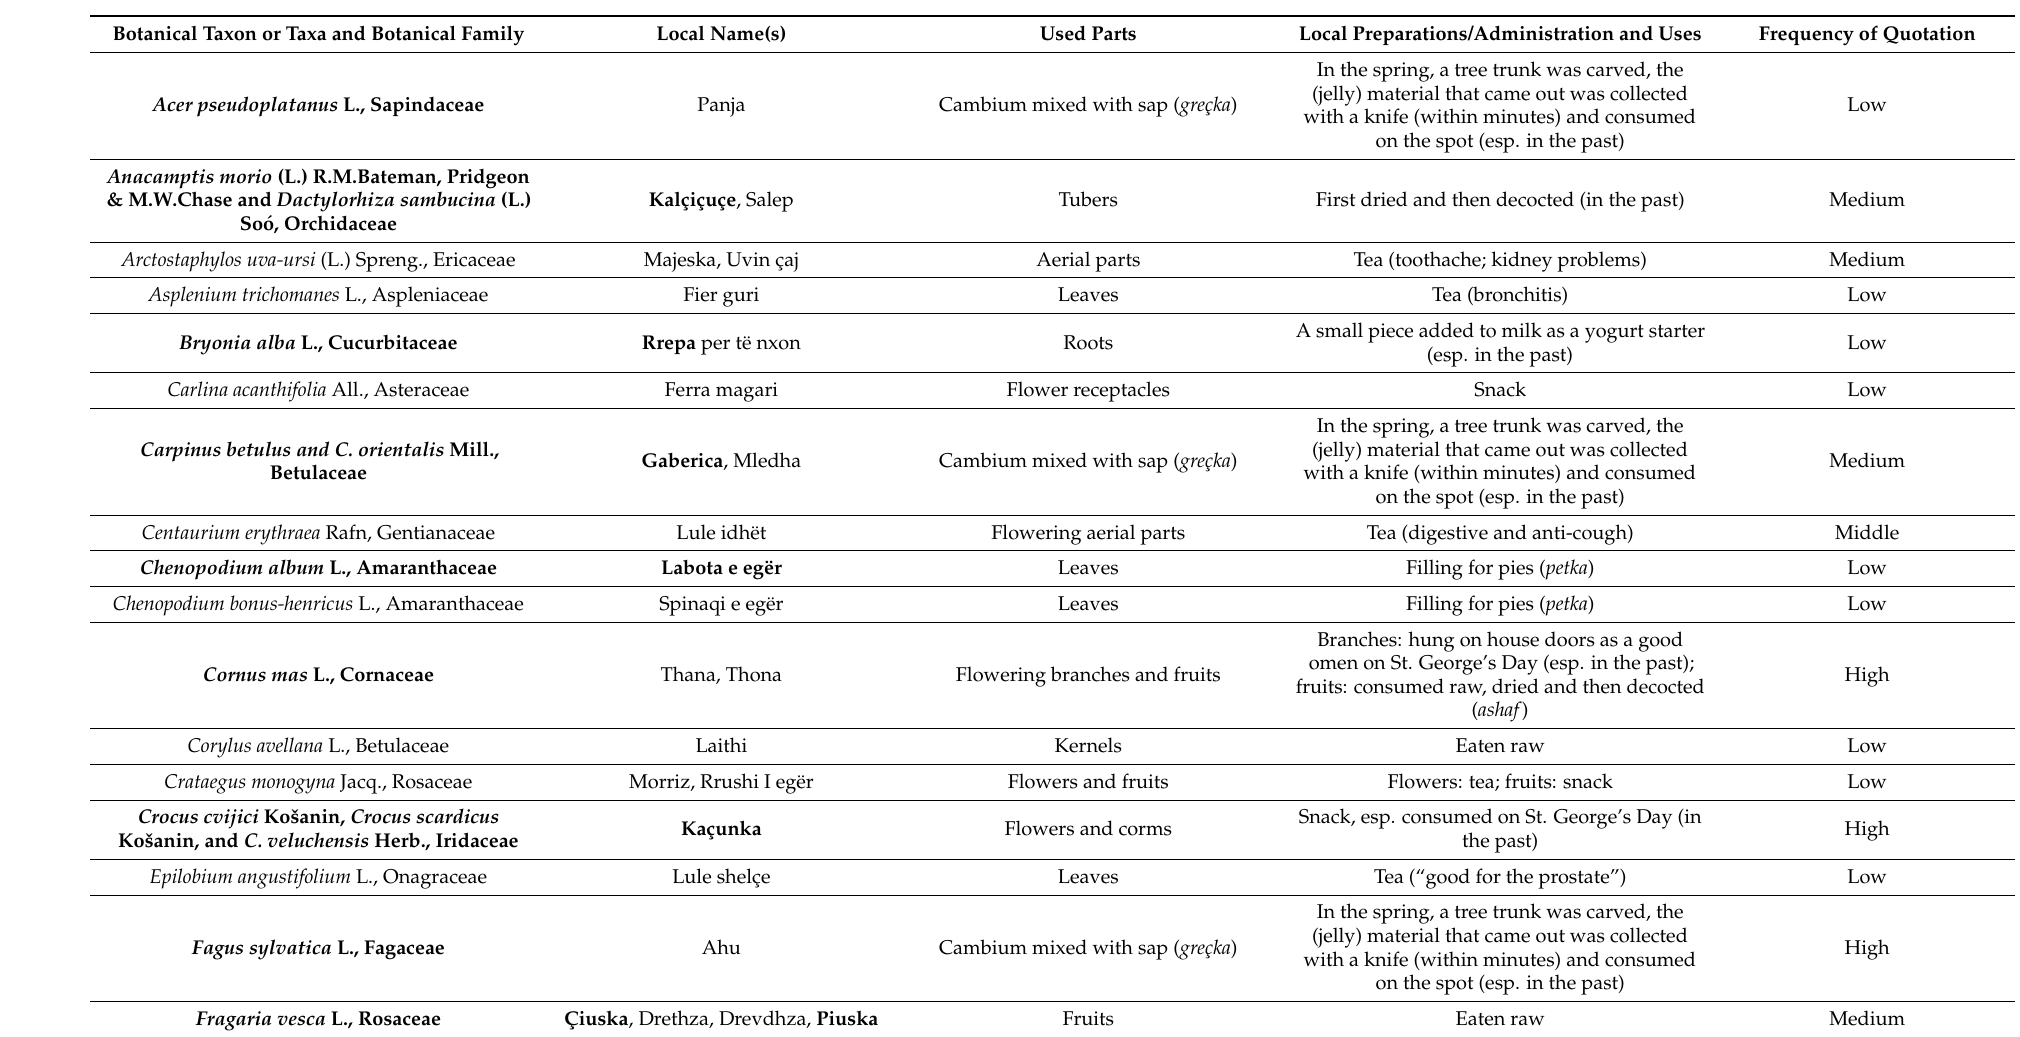
Table 1. Recorded wild plant uses in the study